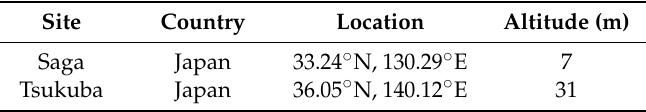
Table 6. Ground-based FTS sites used for CO 2